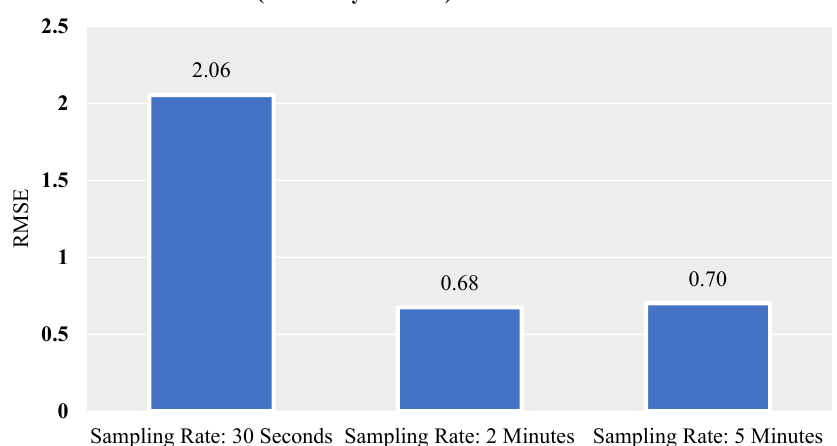
Figure 14. FDU prediction results (stray current) at multiple time components.